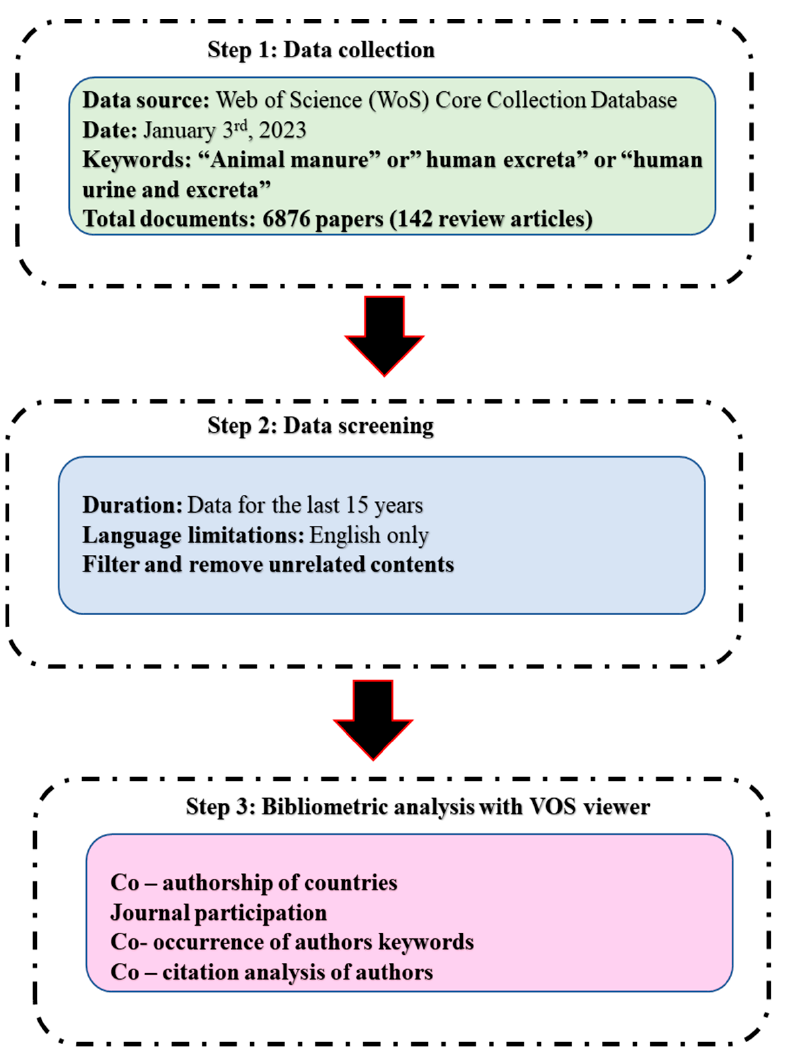
Figure 10. Flow chart of the bibliometric analysis methodology.